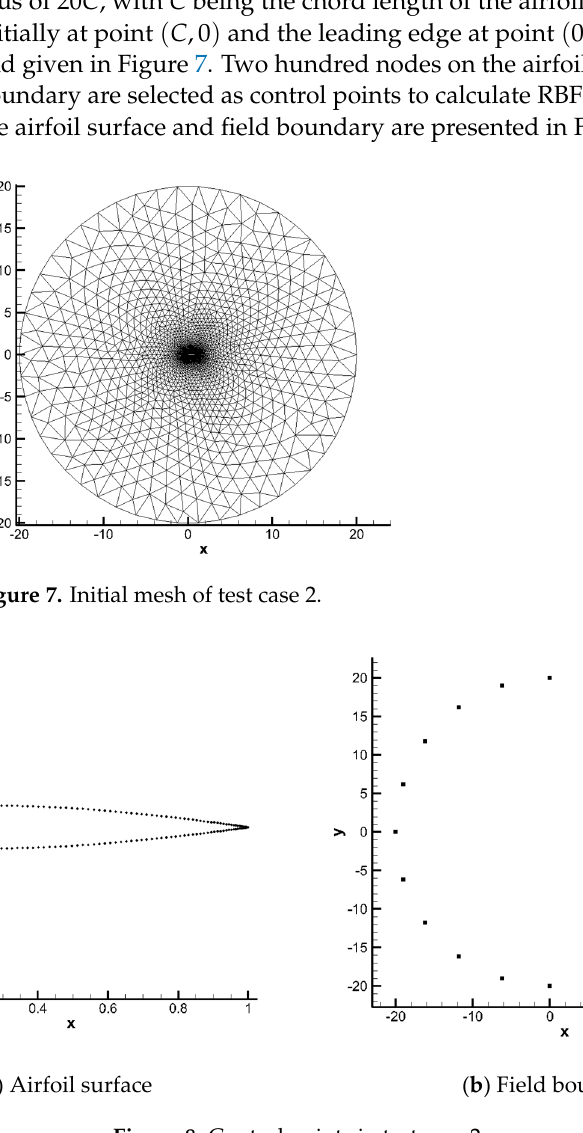
Figure 8. Control points in test case 2.